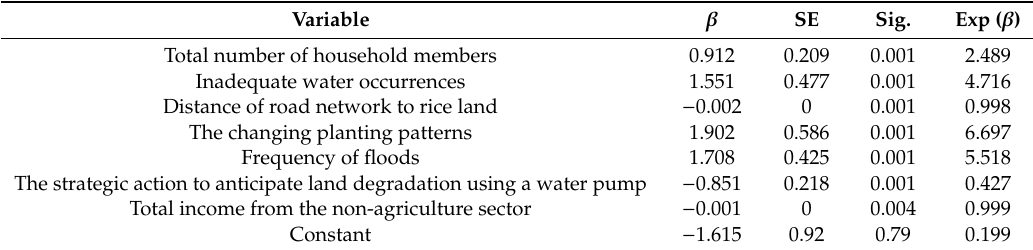
Table 13. The output of the binary logistic regression